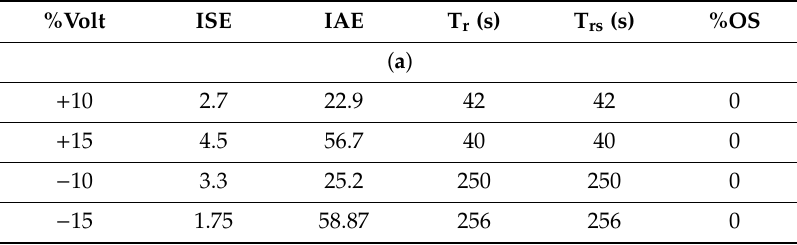
Figure 3. ( a ) Coefficient Diagram based PI Controller (CD ‐ PIC): real time servo response at the 40% Figure 3. ( a ) Coe ffi cient Diagram based PI Controller (CD-PIC): real time servo response at the 40% operating point. ( b ) CD ‐ PIC: real time servo response at the 60% operating point. operating point. ( b ) CD-PIC: real time servo response at the 60% operating point. Table 1. (a) CD ‐ PIC real time step responses at the 40% operating point. ( b ) CD ‐ PIC real time step Table 1. ( a ) CD-PIC real time step responses at the 40% operating point. ( b ) CD-PIC real time step responses at the 60% operating point. responses at the 60% operating